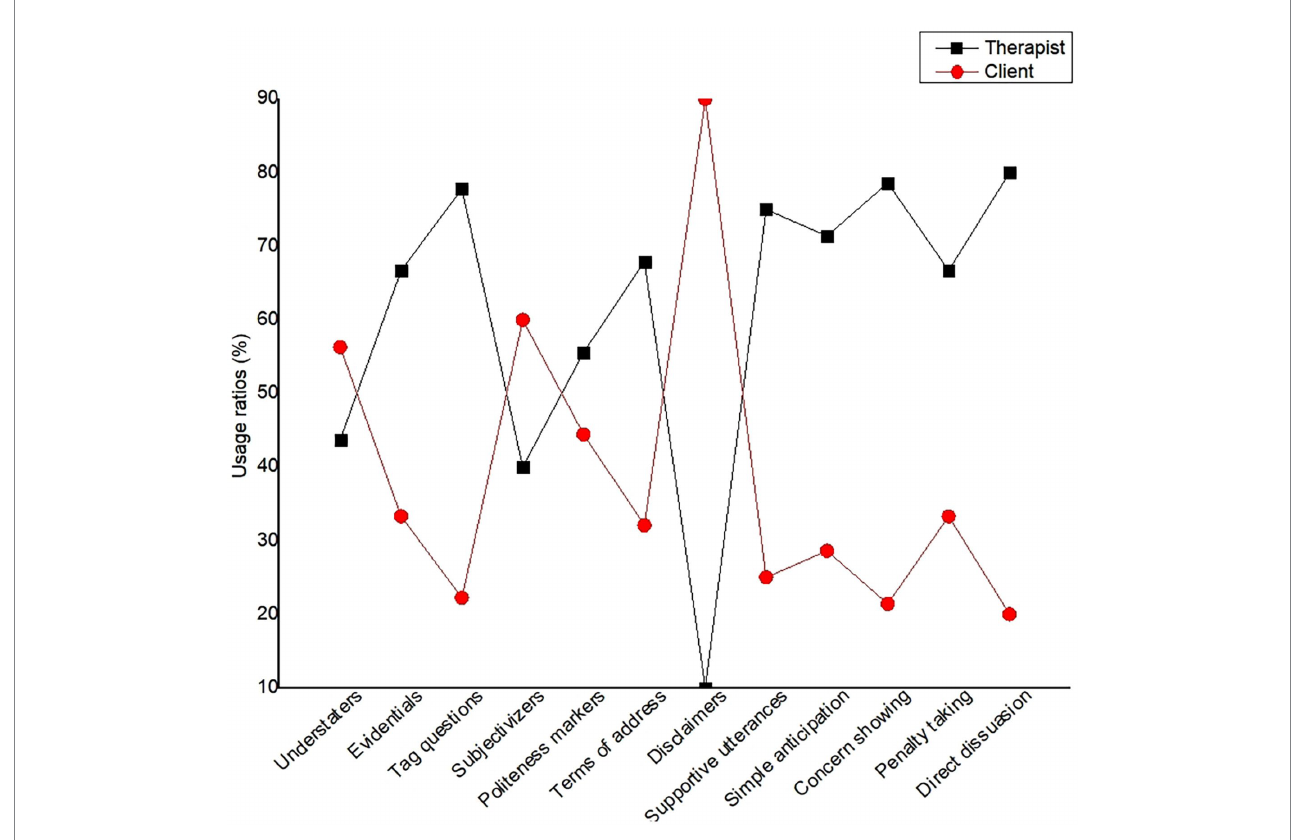
FIGURE 1 Usage ratios for subtype of mitigation for therapists and